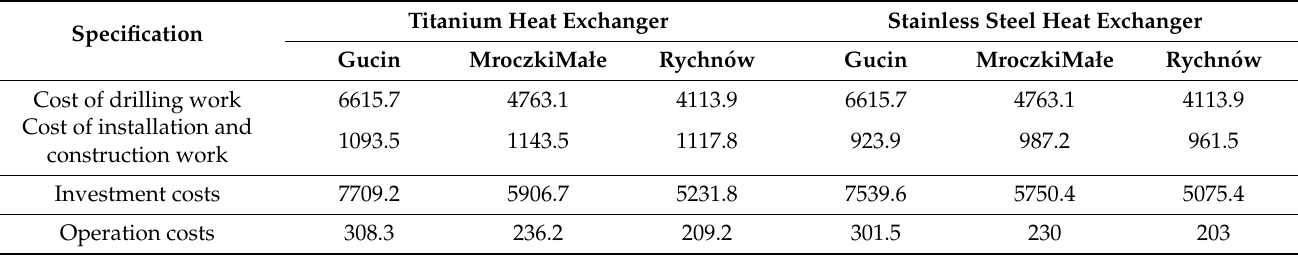
Table 12. Investment and operation costs (in thousand